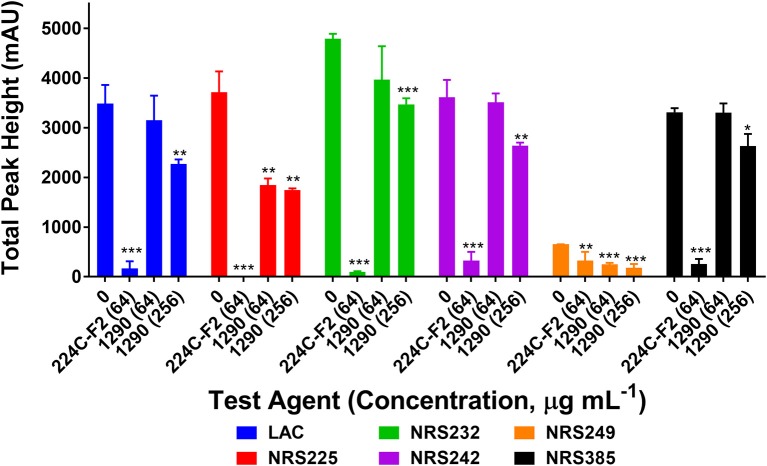
Impact of the ethanolic extract of Zanthoxylum armatum fruits on δ-toxin production (measured by HPLC) in six strains of hypervirulent Staphylococcus aureus (Table 2). Significance was determined in comparison to the vehicle control (DMSO), with *p < 0.05, **p < 0.01, and ***p < 0.001. 224C-F2, a bioactive fraction of Castanea sativa leaf extract (Quave et al., 2015), was used as a positive control (tested at 64 μg mL−1).